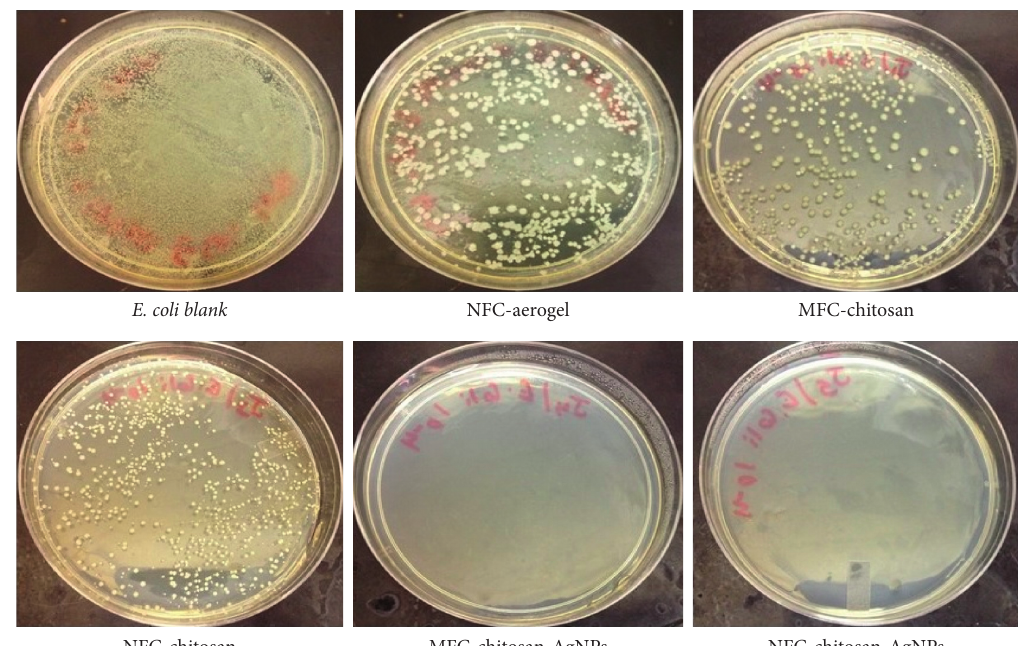
Figure 6: Antibacterial activity of NFC, MFC/chitosan, NFC/chitosan, MFC/chitosan/Ag-NPs, and NFC/chitosan/Ag-NPs against E.